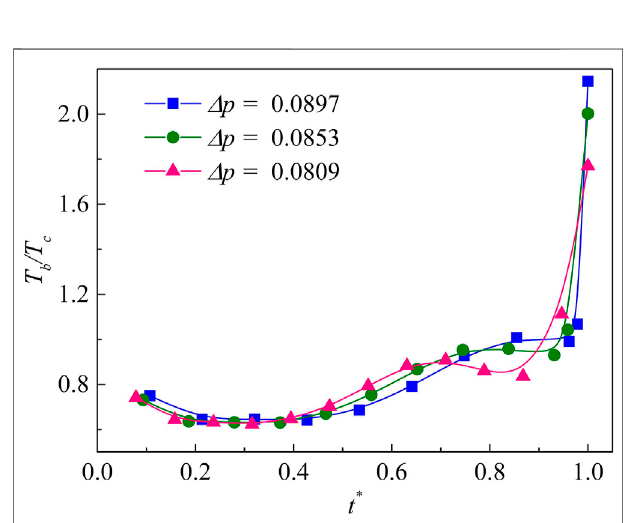
FIGURE 12 | Bubble temperature vs. time for different values of Δ p during the second